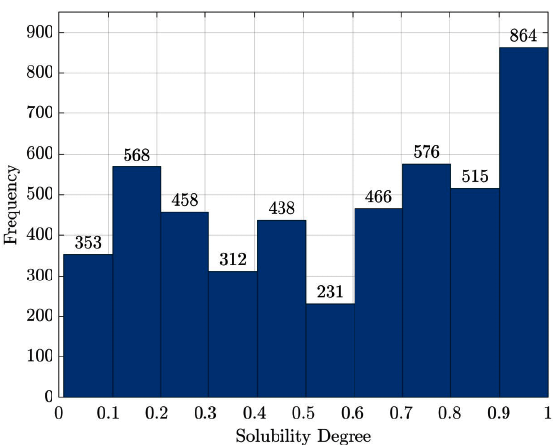
Figure 4. Solubility distribution within the final 4781 proteins